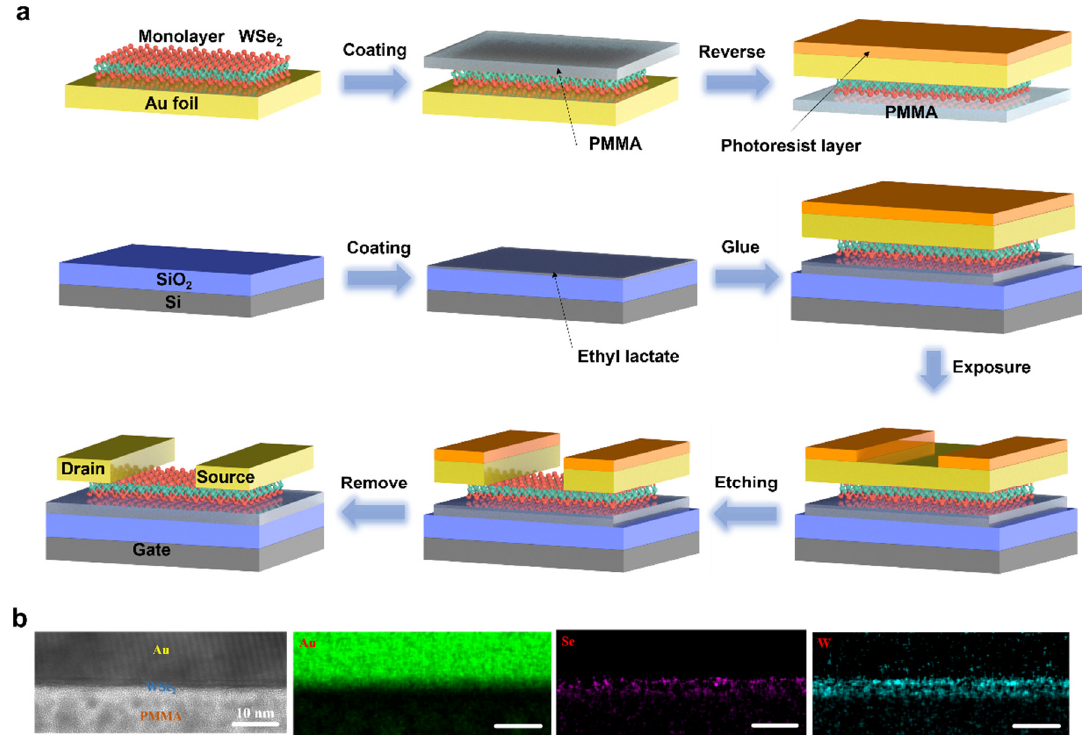
Figure 2. ( a ) Schematic illustration of the transfer-free fabrication process of monolayer WSe 2 FETs. ( b ) HRTEM cross-sectional images of an as-grown WSe 2 on the Au foil, with element distribution pictures. Scale bar is 10 nm.